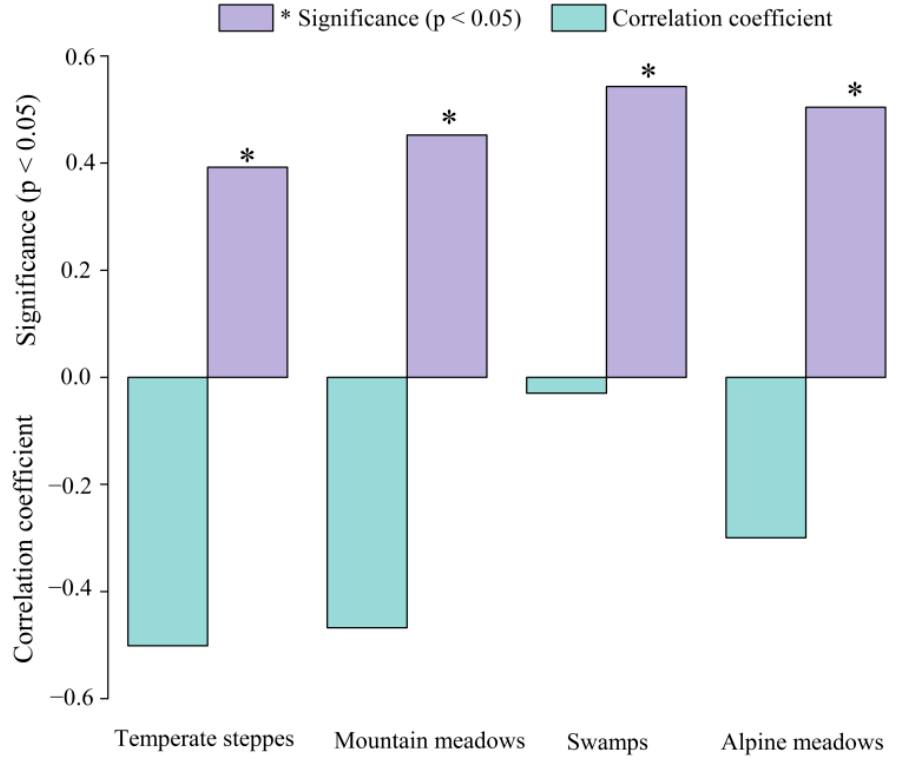
Figure 8. Correlation coefficients of pH and NPP in grassland ecosystems during 2000–2021. * Significant correlation at the 0.05 level (double tail).